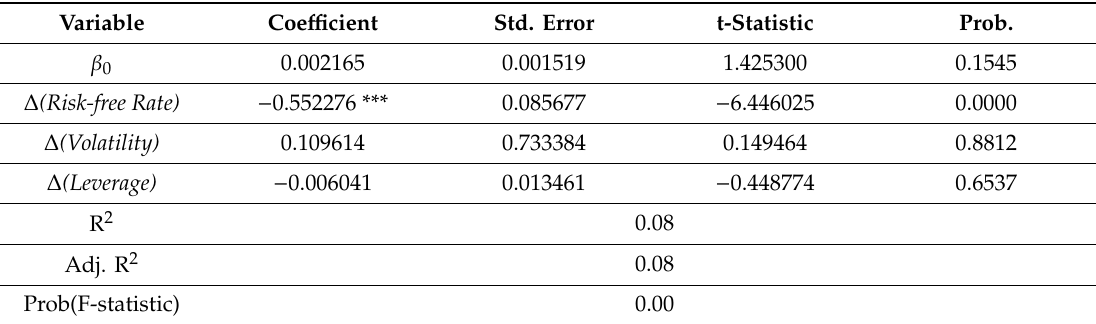
Table A3. OLS estimates: period October 2009–July 2012 (723